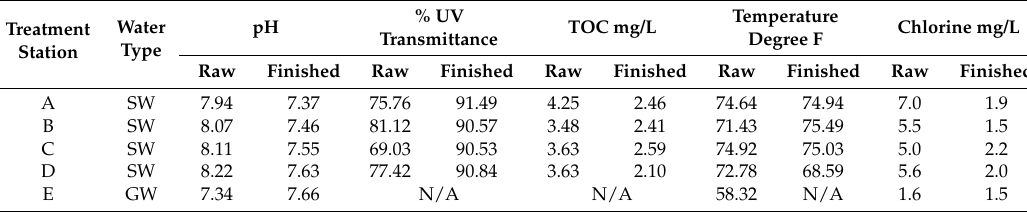
Table 2. Physicochemical properties of raw and finished drinking